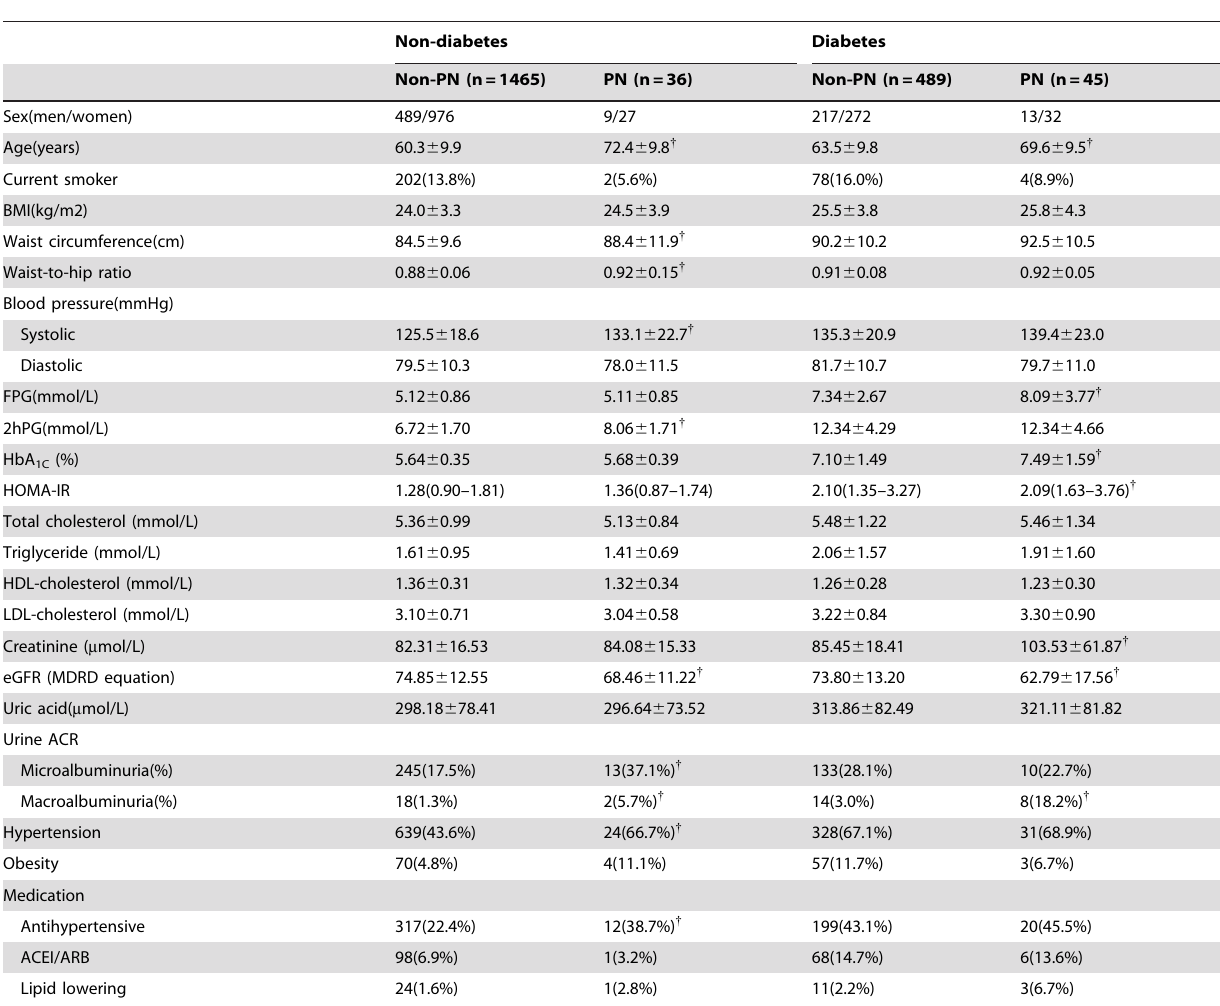
Table 2. Basic features of subjects with and without peripheral